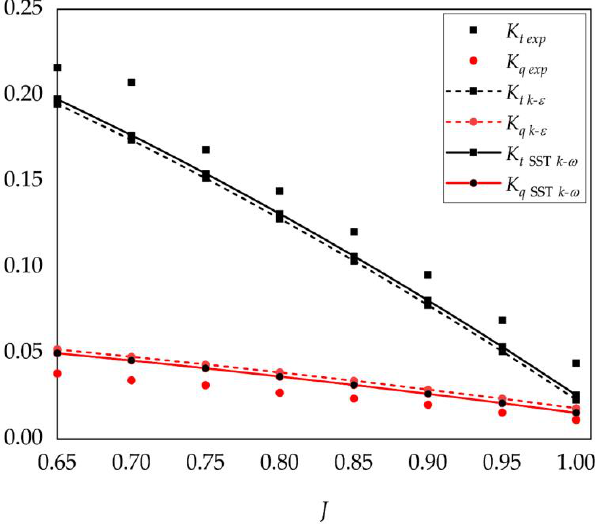
Figure 13. Simulation results compared with experiments ( J = 0.71).